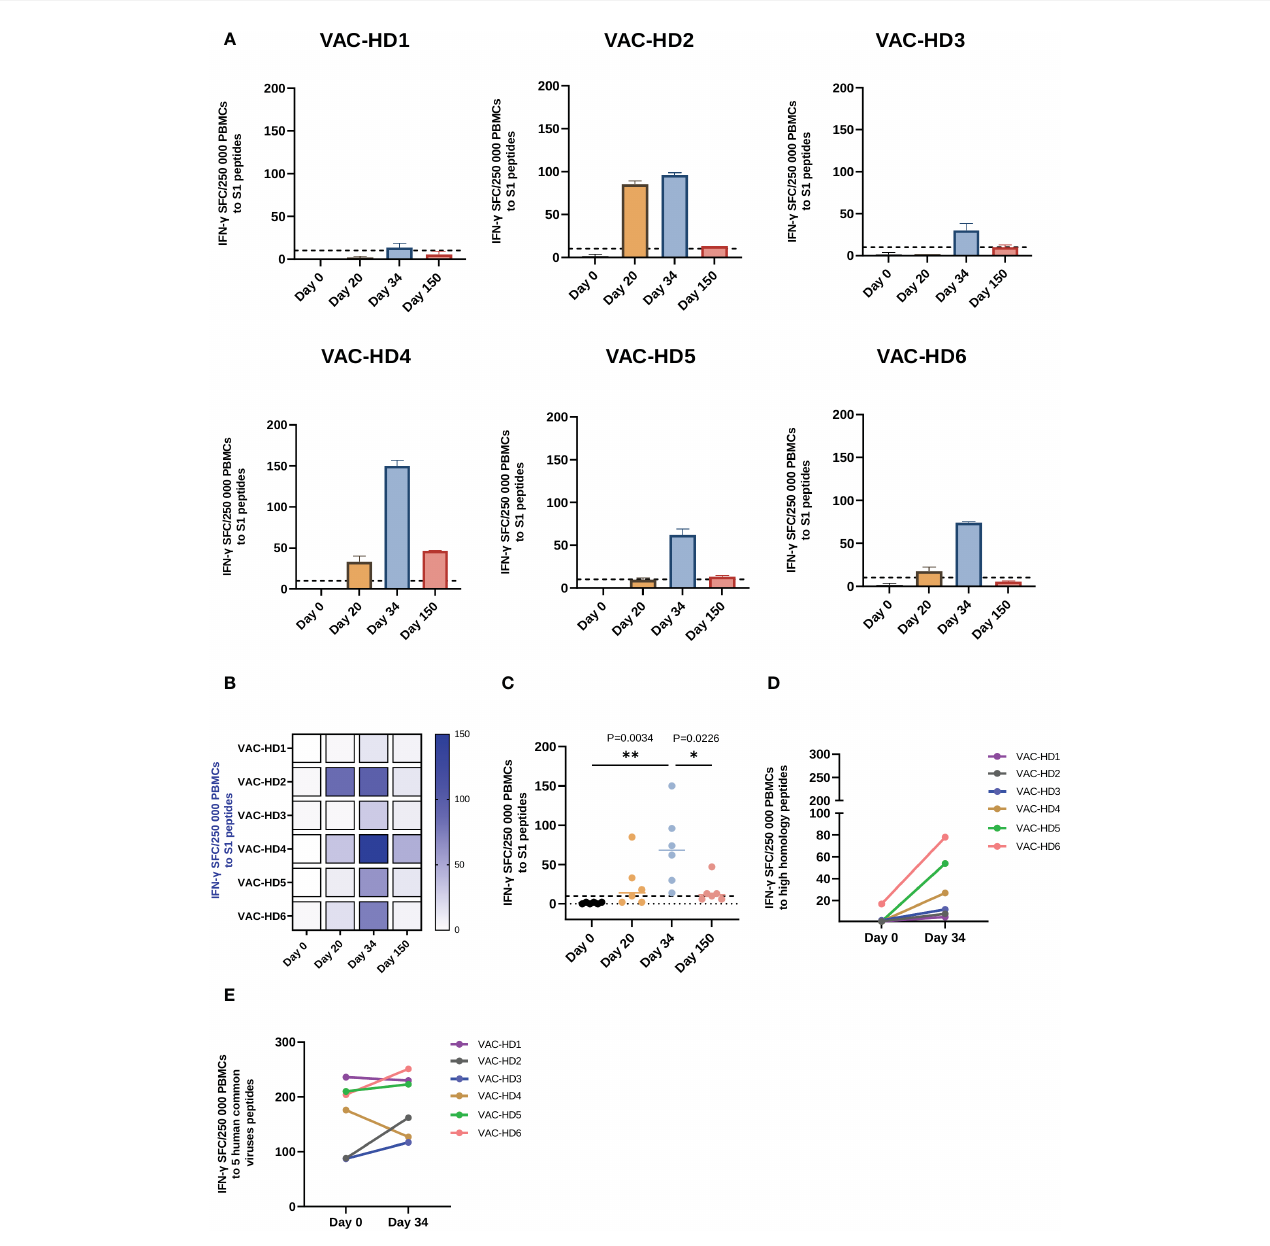
FIGURE 3 Spike-speci fi c and spike cross-reactive T cell responses in BNT162b2 vaccinated participants. (A) T cell response to S1 peptide pools in six BNT162b2 vaccinated participant at the baseline, 20-, 34-, and 150-days post-vaccination. (B) Heat-map of S1- speci fi c T cell responses in six BNT162b2 vaccinated participants over time (C) Dynamics of S1- speci fi c T cell responses in six BNT162b2 vaccinated participants over time. Each symbol represents an individual participant with a line indicating the median of each time point. (D) T cell response to high homology peptide pools in BNT162b2 vaccinated participants at baseline (Day 0) and on day 34 post-vaccination (after the second dose) (E) T cell response to fi ve human common viruses peptides (CMV, EBV, AdV 3 and 5 and BKV) in BNT162b2 vaccinated participants at baseline (Day 0) and on day 34 post-vaccination (after the second dose). Results are presented as the mean of the number of spots forming cells (SFCs) per 250 000 PBMCs subtracting the background (negative control) count. A positive response was de fi ned as an SFCs of 10 or more. One-way ANOVA test was used, P value was considered statistically signi fi cant when *P ≤ 0.05. All samples were run in duplicates. The stars present the level of signi fi cance. *P < 0.05; **P <